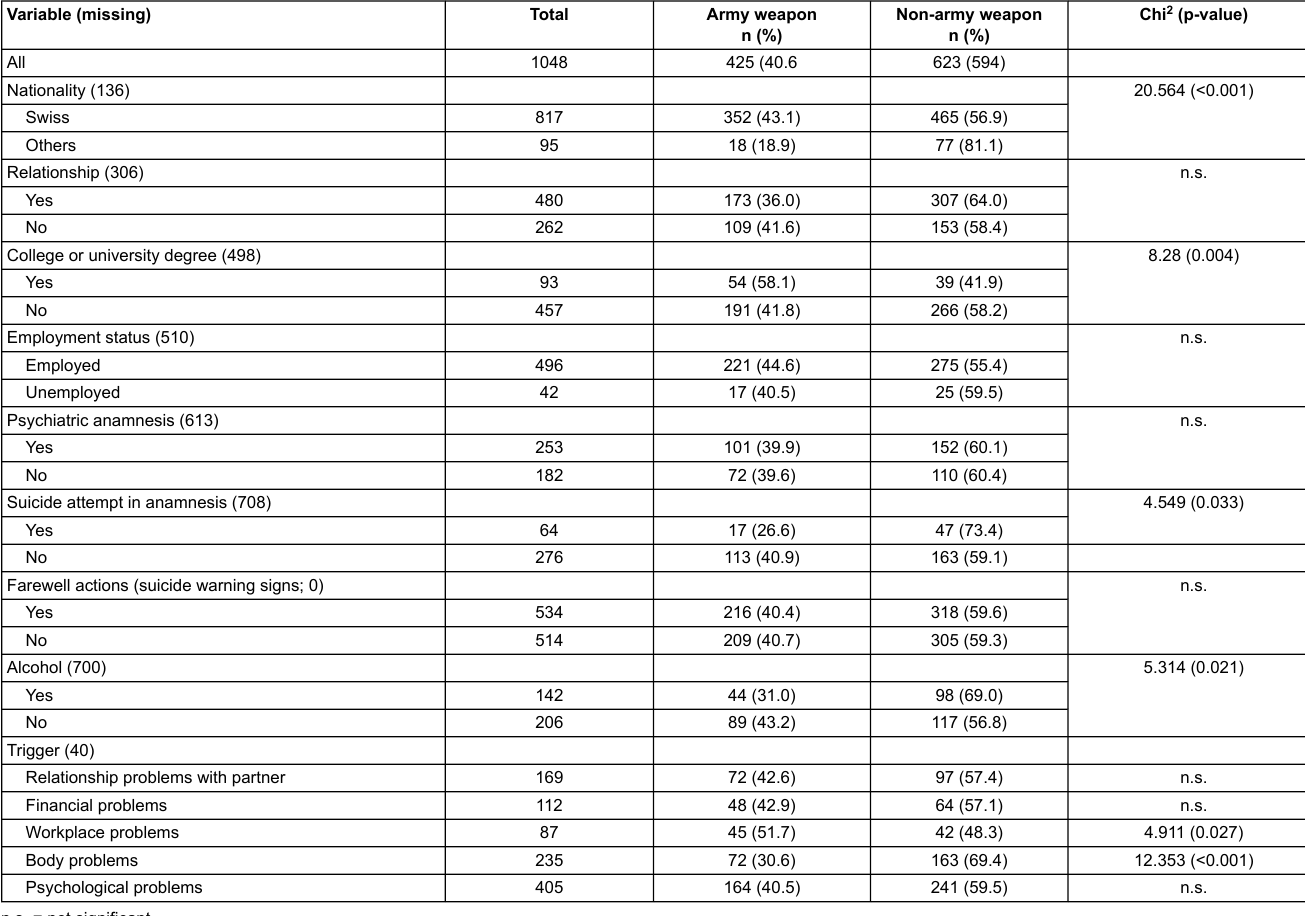
Table 3: Sociodemographic comparison of suicides committed by army weapons and non-army weapons (males only) . Variable (missing)